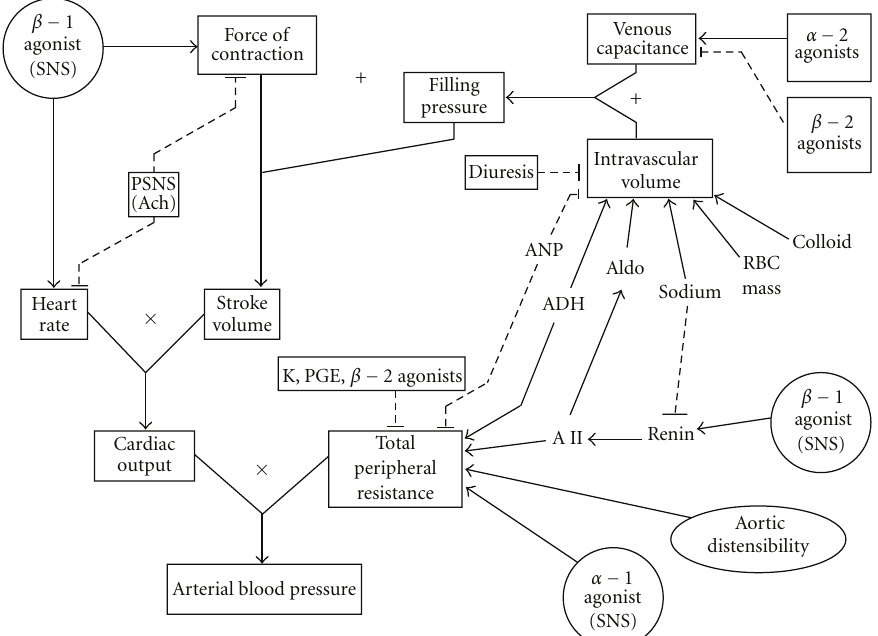
Figure 1: Factors that determine the arterial blood pressure (adapted with permission from [25]).